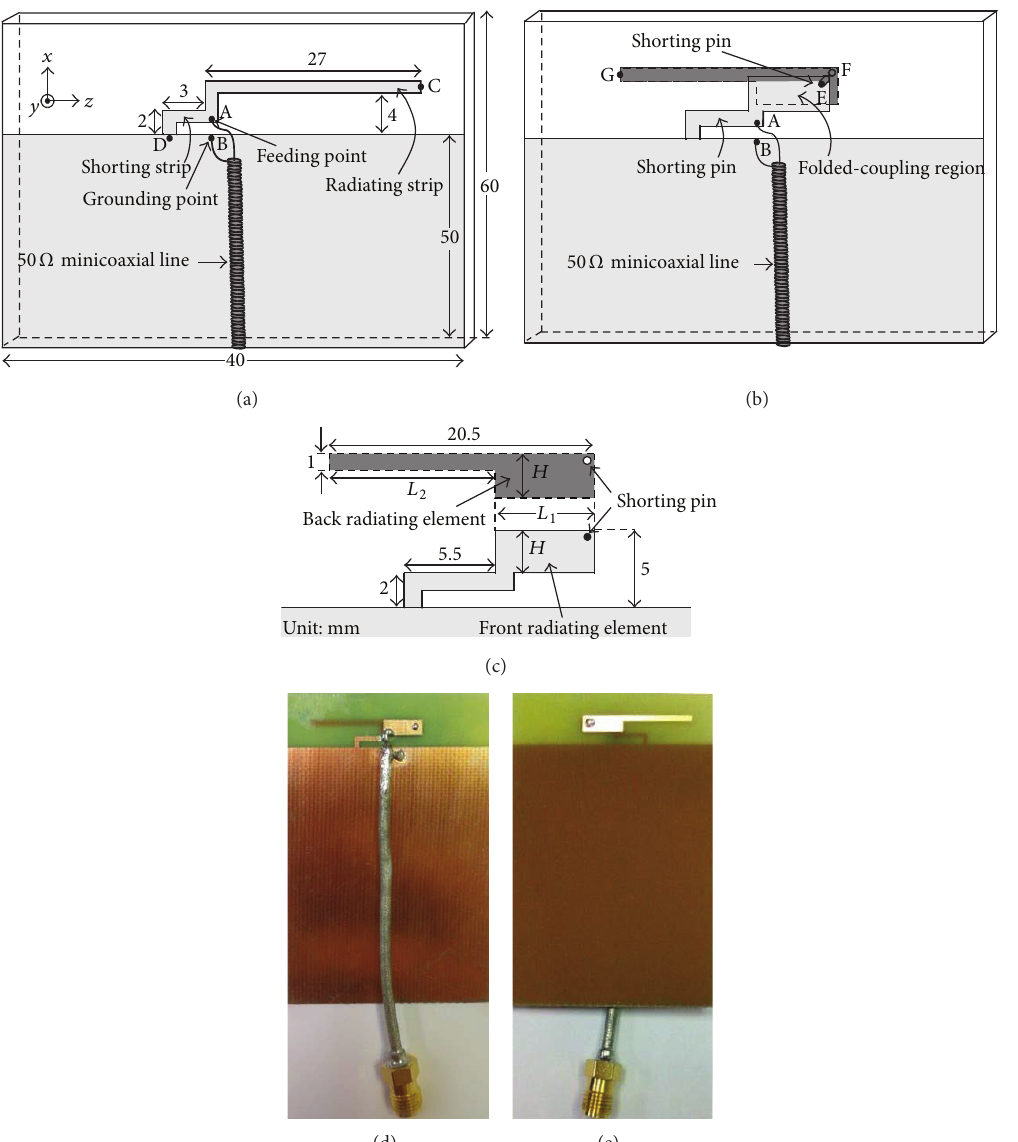
Figure 1: Geometry of (a) the conventional PIFA (reference antenna), (b) the proposed dual-band FC-PIFA for WLAN communications, and (c) the parameters of the folded-coupling region in (b); photograph of proposed FC-PIFA for (d) the front side and (e) the back